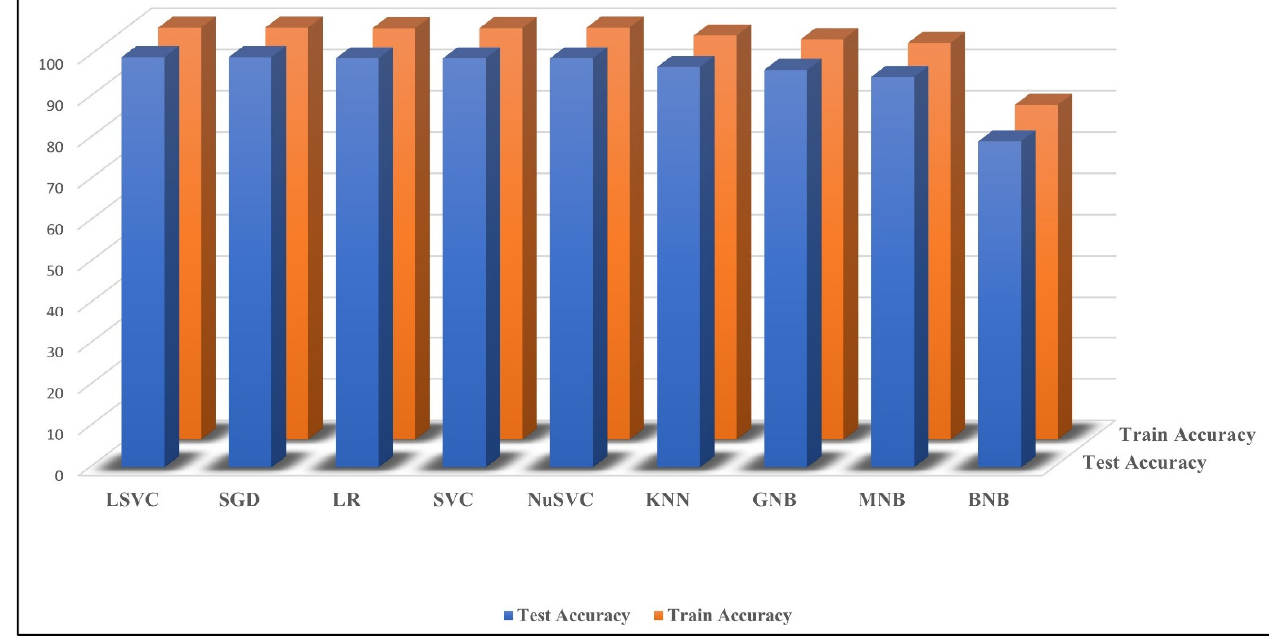
Fig. 8: Train vs Test Accuracy